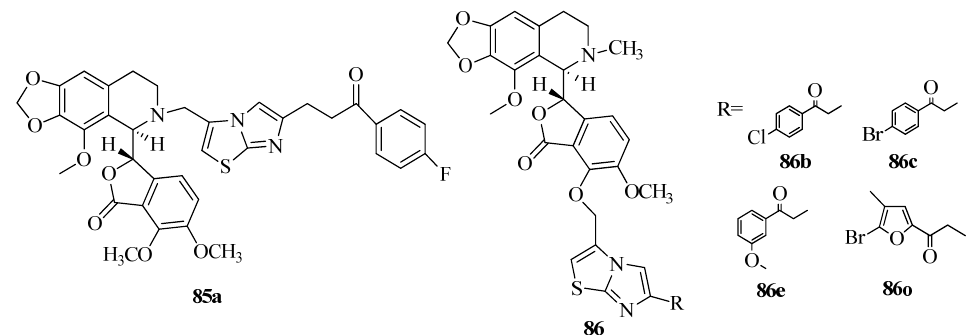
Figure 33. Structures of imidazo[2,1-b]thiazole-coupled noscapine